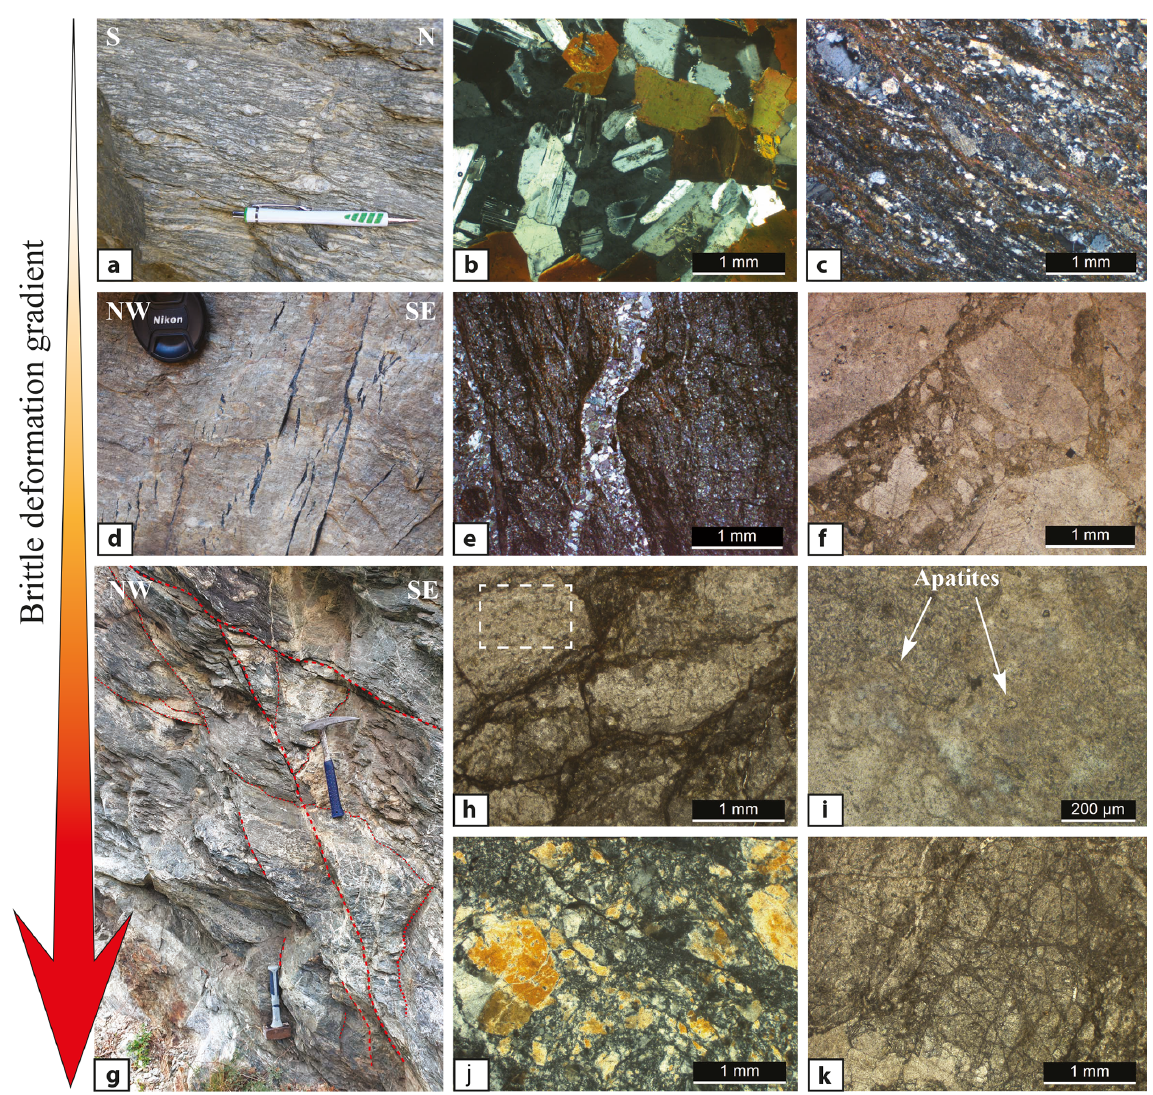
Figure 6. Outcrop and microscopic images of crystalline rocks near the Têt fault (eastern Pyrenees) showing a brittle deformation gradient. Samples outside the damage zone (DZ): (a) typical Canigou augen gneiss; (b) thin section of undeformed Mont-Louis granite, ST12 sample; (c) Variscan mylonite unaffected by fractures. Samples from the outer DZ: (d) silica-filled fractures in mylonites close to CAR7 sample; (e) thin section of previous mylonites with quartz-filled fracture; (f) fracture filled with a micro-breccia near the St Thomas (ST) hot spring cluster. Samples from the inner DZ: (g) intense fracturation in the footwall near the Têt fault on ST profile close to samples ST15 and ST16; (h) thin section of a heterogeneously fractured and altered gneiss (close to sample ST15) showing gneiss lenses less affected by hydrothermal alteration; (i) close view of apatite grains within a gneiss lens (enlargement of dashed rectangle in h ); (j) thin section of cataclasite next to the Têt fault core; (k) thin section of proto-cataclasite next to the Têt fault